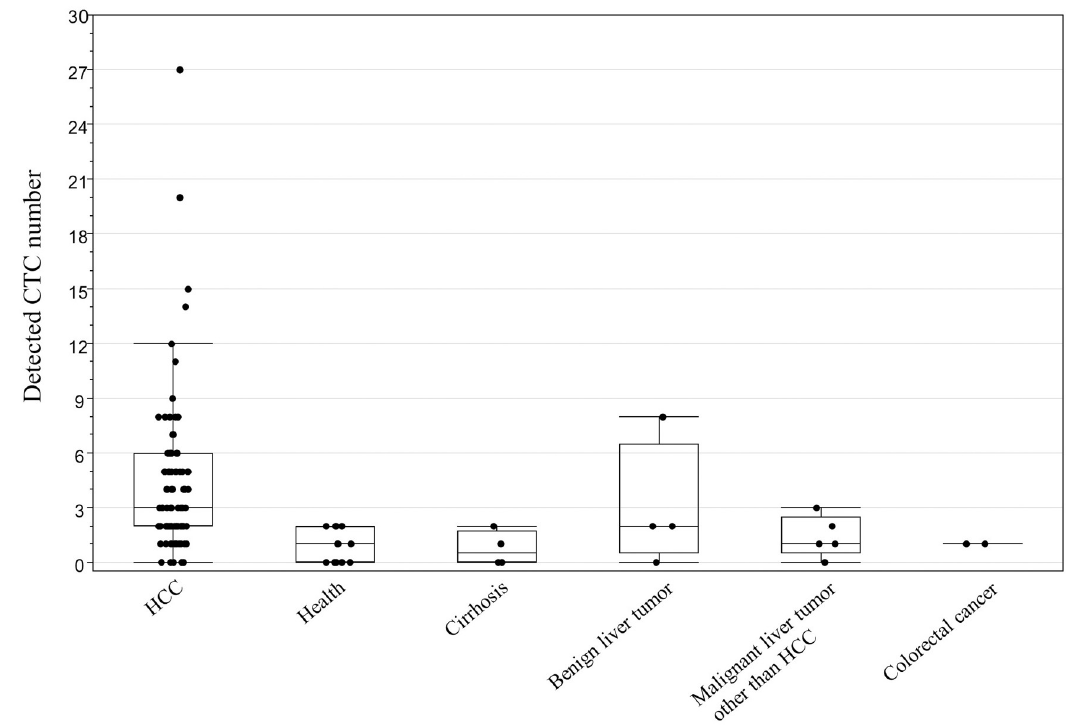
Fig 4. Dot and box-plots of GPC3-positive CTC count. Distribution of GPC3-positive CTCs in HCC patients (n = 85), healthy volunteers (n = 12), cirrhotic patients (n = 4), patients with benign liver tumors (n = 4), patients with malignant liver tumors other than HCC (n = 5), and patients with colorectal cancer (n = 2).